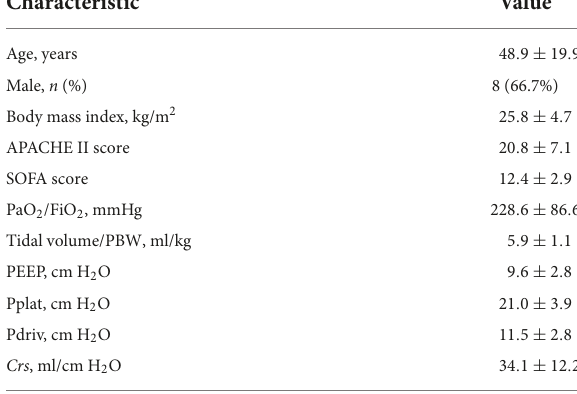
TABLE 1 Baseline characteristics of the patients ( n =